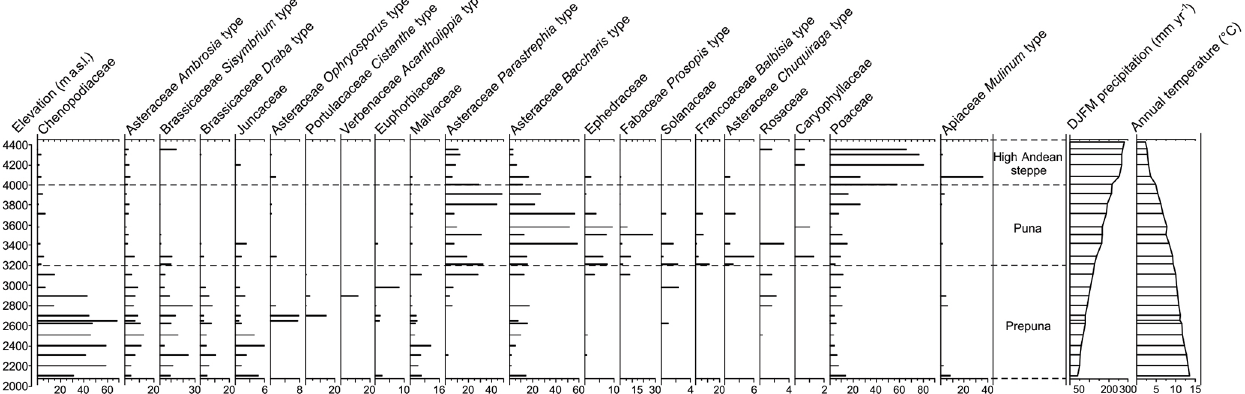
Figure 3. Diagram with the altitudinal position of the 26 surface pollen assemblages collected along a west–east transect on the western Andes slope at 18 ◦ S. The elevation ranges of the main vegetation belts are shown along with the summer precipitation and annual temperature obtained using the WorldClim2 dataset (Fick and Hijmans, 2017).